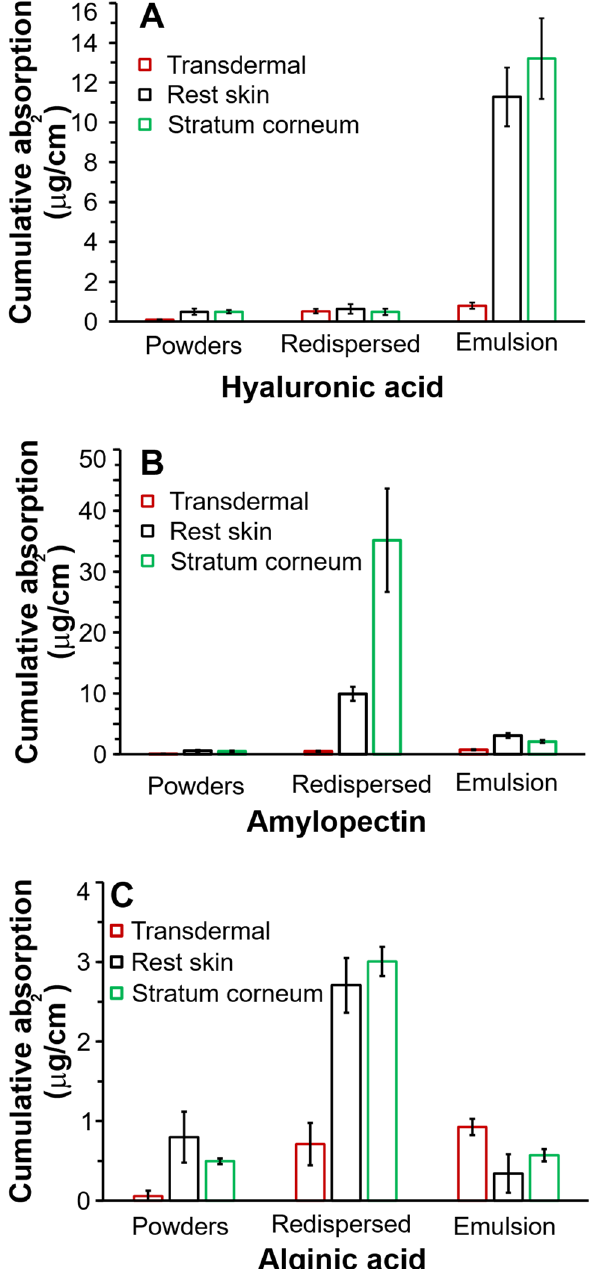
Figure 5. Average in vitro skin absorption data of griseofulvin from ( A ) hyaluronic acid, ( B ) amylopectin, and ( C ) alginic acid-stabilized formulations through human abdominal skin expressed as total amount delivered over 24 h. Three skin donors were used, with 6 repetitions per skin donor per formulation.